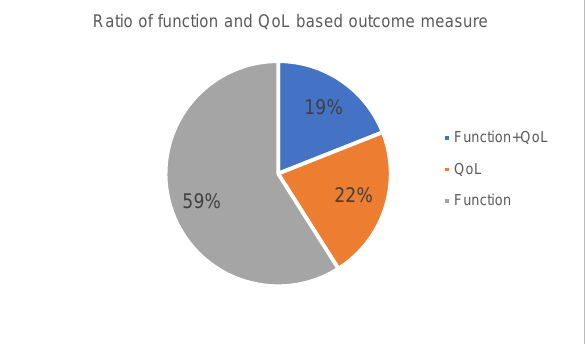
Figure 3 : Pie chart showing that most outcome measures assess function, with a smaller proportion assessing